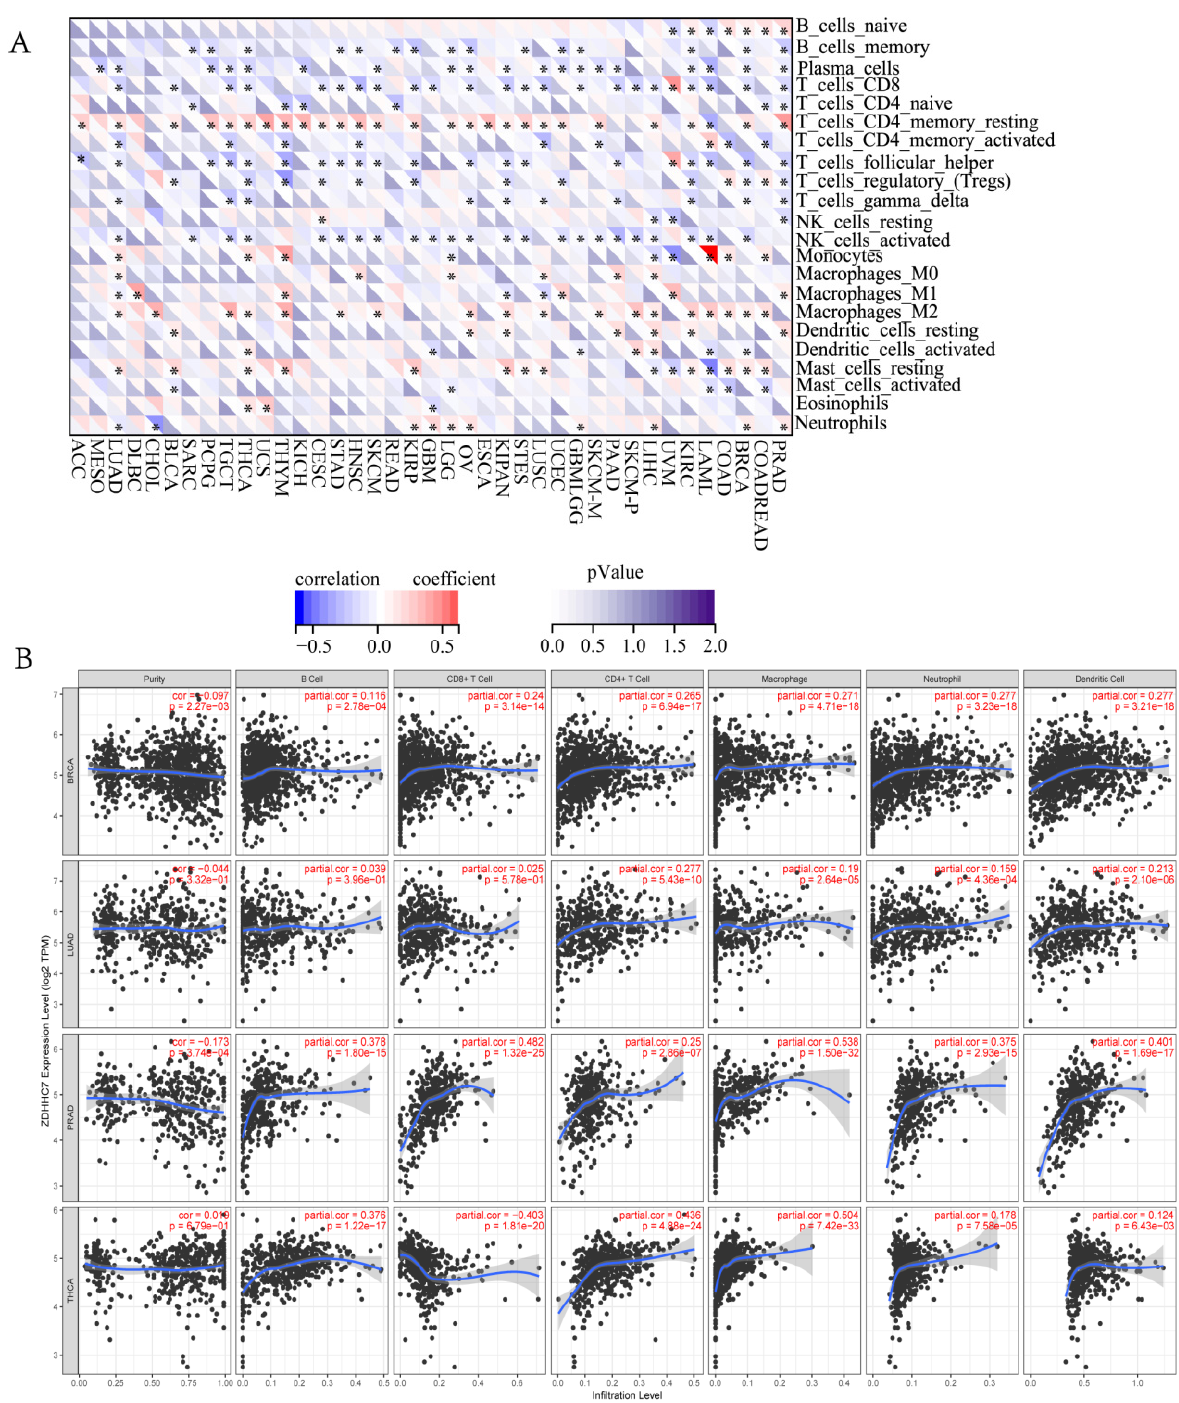
Figure 6. Correlation of ZDHHC7 expression with immune infiltration levels across cancer types. ( A ) Correlation of ZDHHC7 expression with the infiltration level of immune cells by the CIBERSORT algorithm. Immune cells positively correlating with ZDHHC7 expression are labeled in red, and immune cells negatively correlating with ZDHHC7 expression are labeled in purple. ( B ) Correlation of ZDHHC7 expression with immune infiltration level in BRCA, LIHC, LUSC and